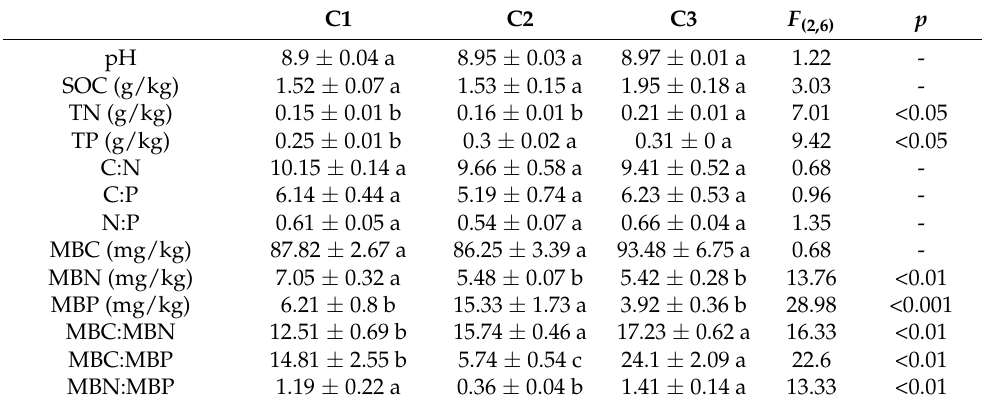
Table 1. The soil properties of compound soils with different feldspathic sandstone-to-sand ratios. C1